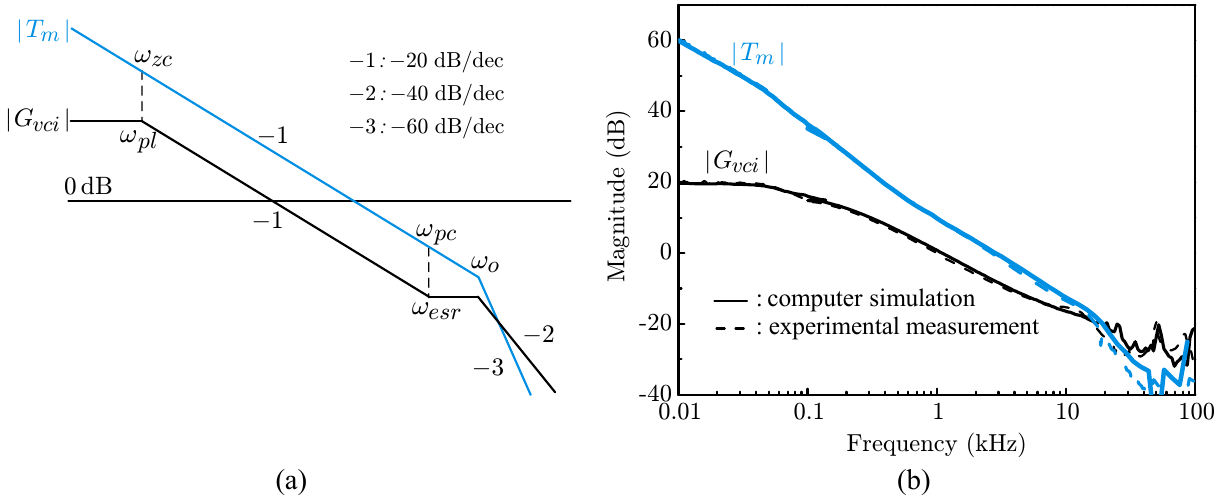
Figure 8. Voltage feedback compensation design. ( a ) Design strategy. ( b ) Design